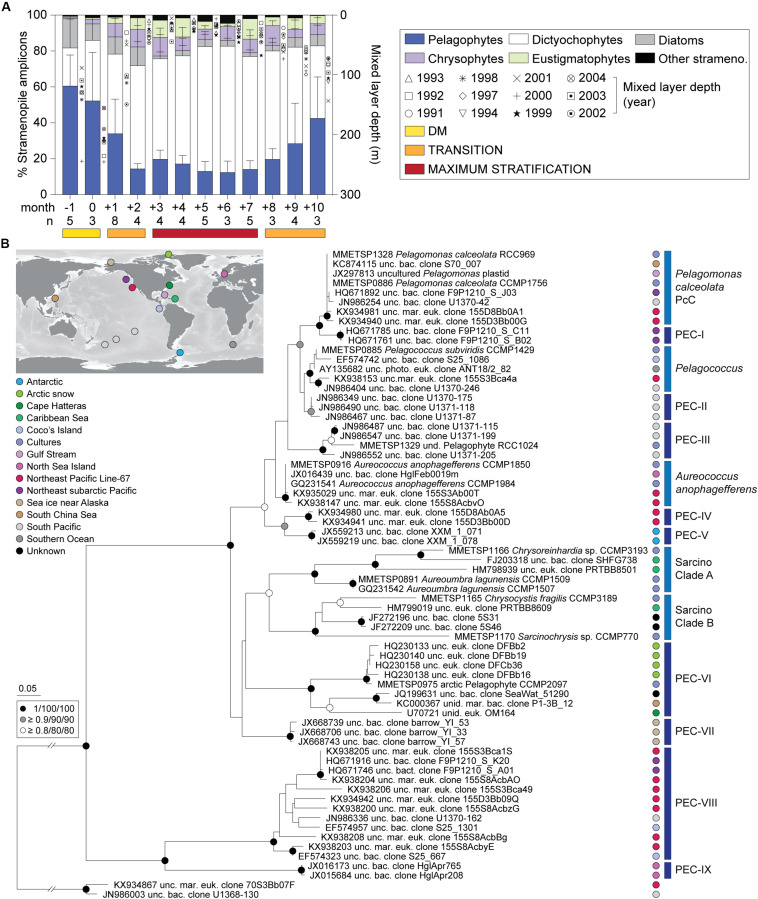
Photosynthetic stramenopile class distributions in the northwestern Sargasso Sea and reference trees for finer-scale analyses. (A) Photosynthetic stramenopile distributions expressed as a percentage of amplicons phylogenetically assigned to stramenopile classes at BATS surface (0.3–7.6 m). Error bars represent the standard deviation and ‘n’ indicates the number of samples used for the analysis. Phylogenetic reference trees were developed to then resolve clades within the (B) pelagophytes and dictyochophytes (Supplementary Figure S5) using near full-length 16S rRNA gene sequences. For pelagophytes, sequences came from nine cultured species, 56 environmental clones and two dictyochophyte sequences as an outgroup. The tree was constructed with Maximum Likelihood inference (RAxML) under the gamma corrected GTR model of evolution with 1,000 bootstrap replicates. Additional phylogenetic reconstructions were performed with PhyML and MrBayes and the node statistical supports are indicated. Five known clades were resolved and previously unrecognized nine additional clades were identified Pelagophyte Environmental Clades I-IX (PEC-I to PEC-IX). These were primarily comprised of environmental sequences. Colors indicate oceanic region of origin.